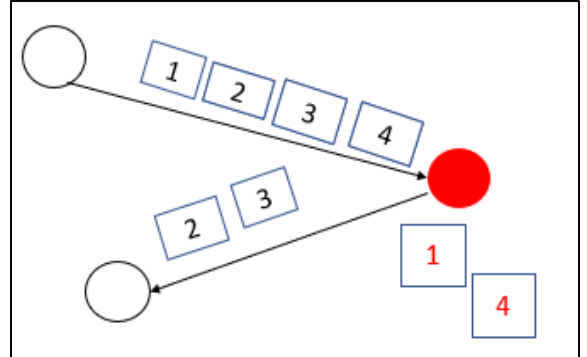
Figure 4. An illustration of the Greyhole attack